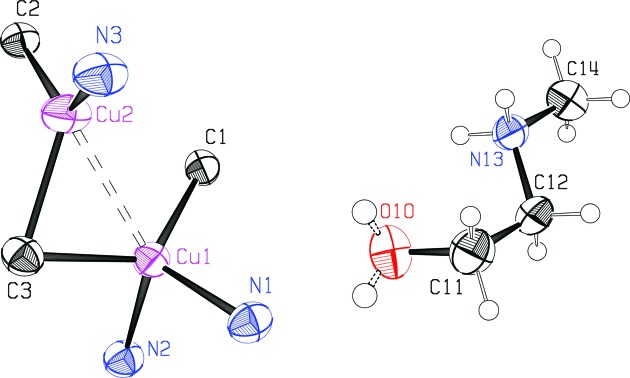
The asymmetric unit of the title com­pound, showing displacement ellipsoids for heavier atoms at the 70% probability level and H atoms at an arbitrary scale. Both of the disordered hy­droxy O atoms are shown. The dashed line indicates the cuprophilic inter­action. In this figure, as well as in Figs. 4 ▸ and 5 ▸, the color code is: Cu magenta; O red; N blue; C black.